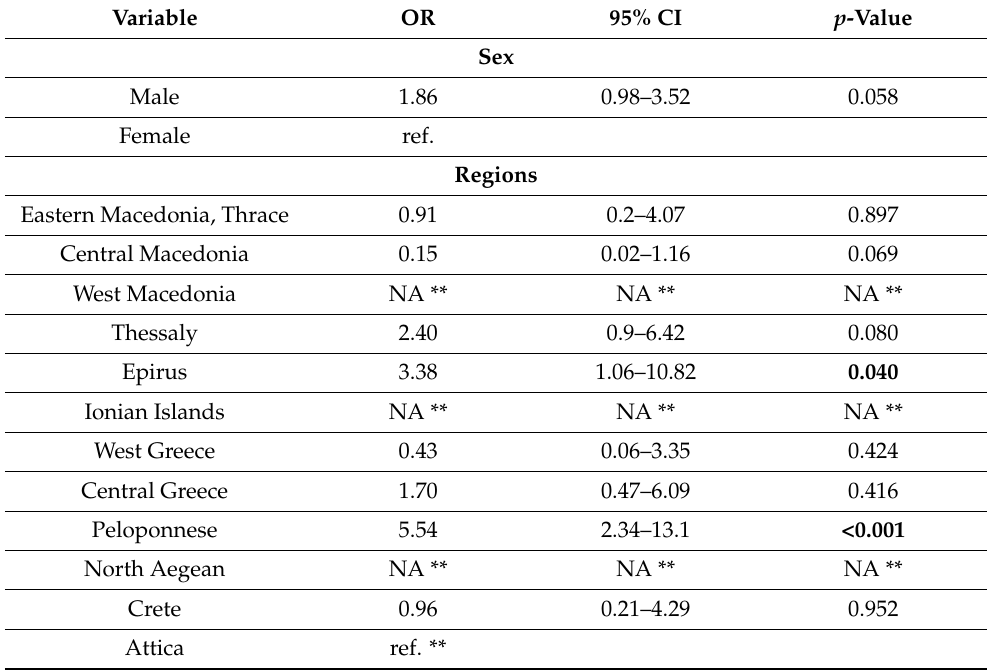
Table 4. Multinomial logistic regression (MLR) analysis (positive samples).